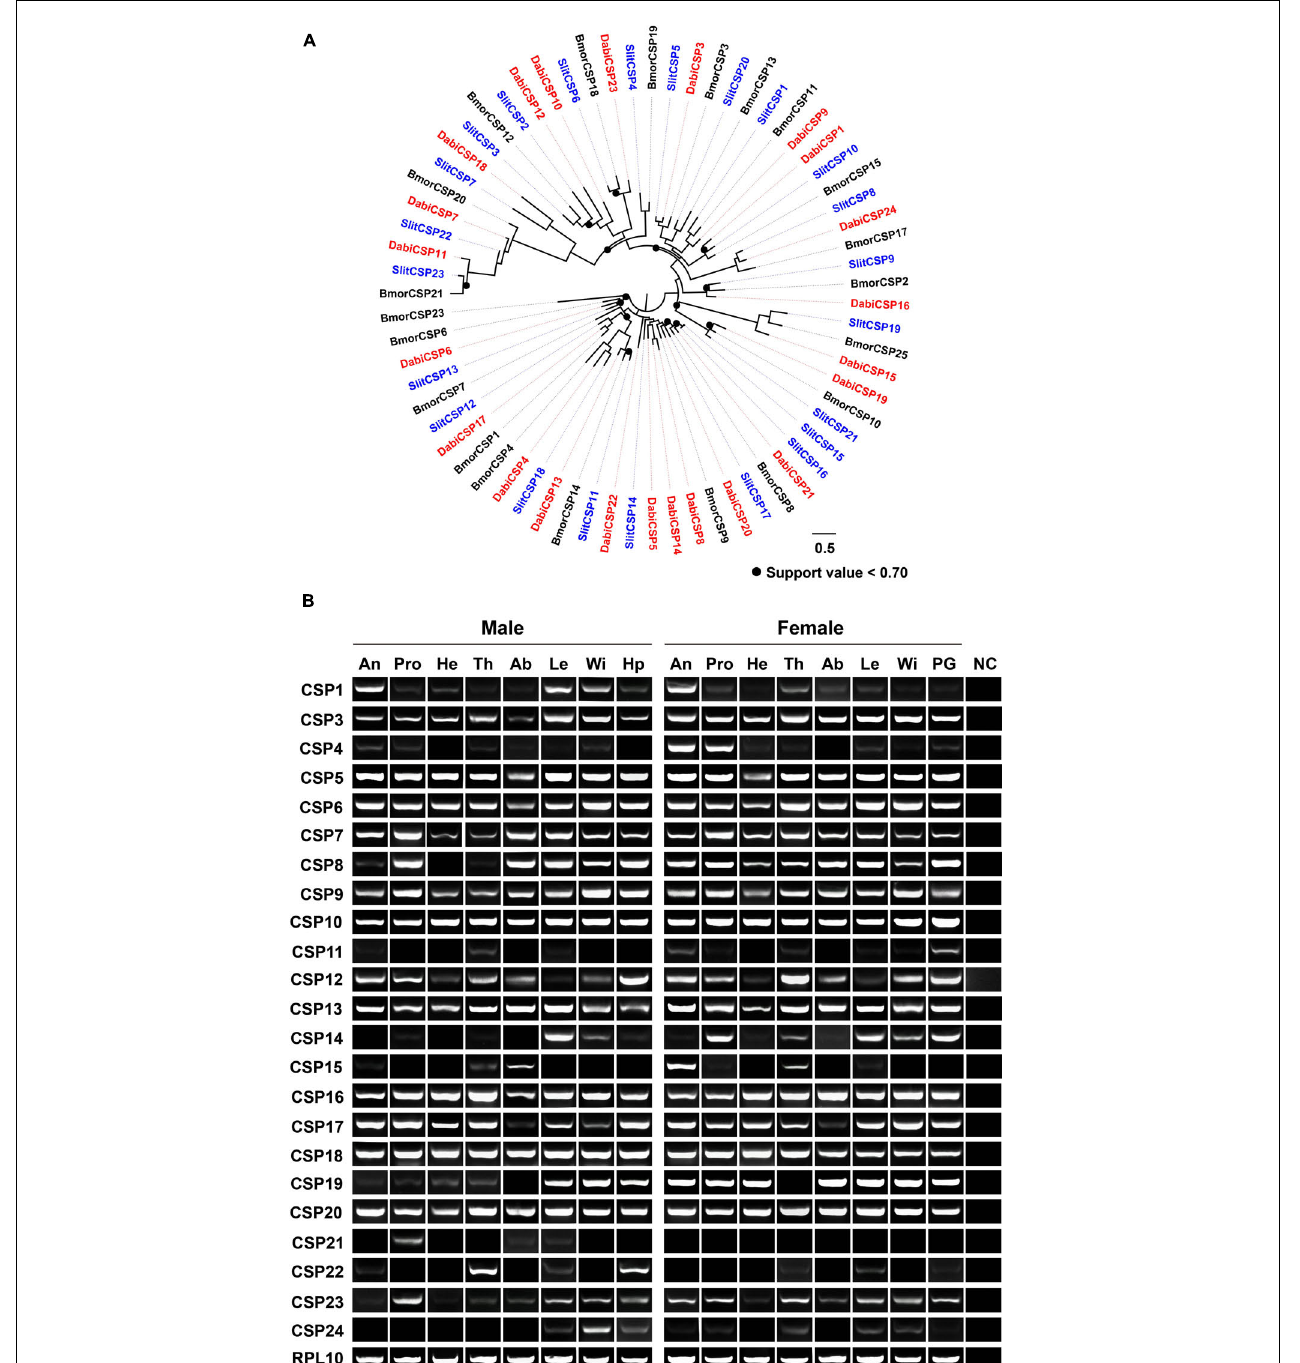
FIGURE 3 | The candidate CSP gene family in D. abietella . (A) The phylogeny of CSPs in S. litura (Slit, blue), D. abietella (Dabi, red), and B. mori (Bmor, black). (B) Expression profiles of DabiCSPs in different tissues of both sexes from D. abietella . A reference gene, DabiRPL10 , was used to check the quality and quantity of cDNA templates. NC, negative control using sterile water as the template. The full names of tissues are listed in Table 1 .